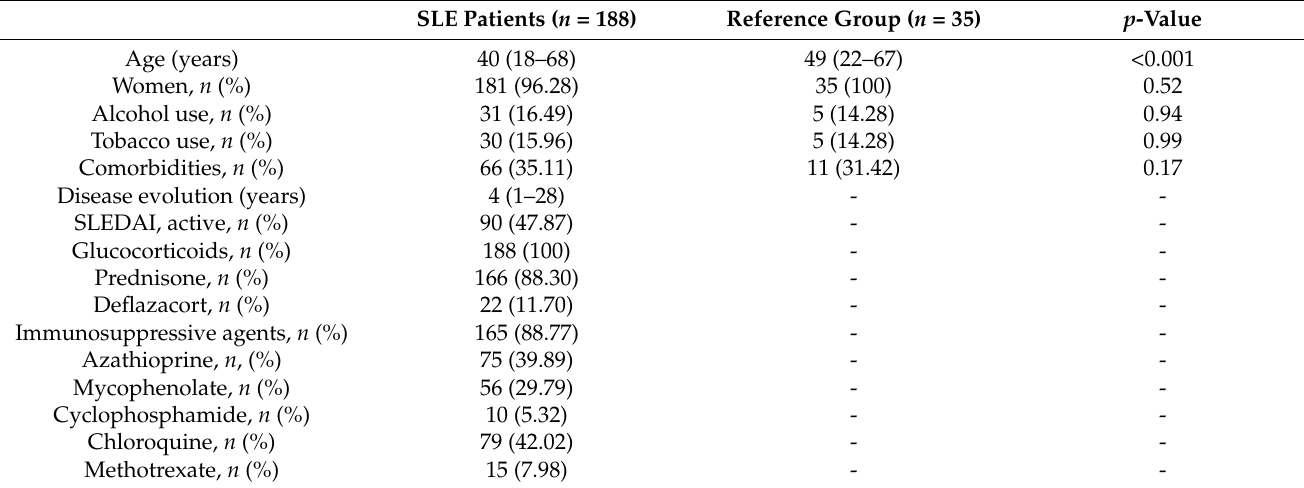
Table 1. Clinical characteristics of the SLE patients and the reference group in this